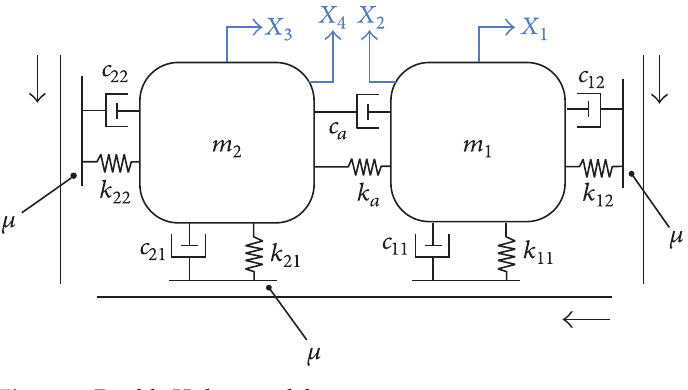
Figure 1. Double Hulten model.